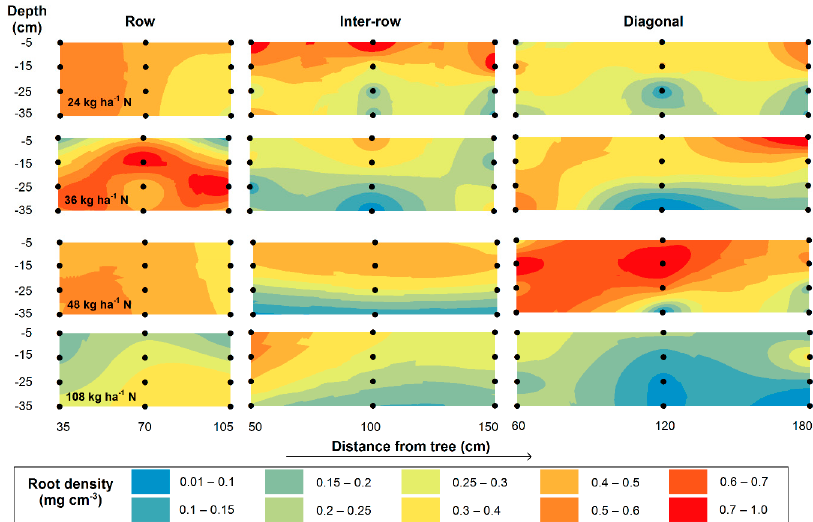
Figure 4. Ordinary kriging of average fine-root density ( FRD ) distribution of 2.95-year-old E. dunnii Maiden along soil profile in the three positions evaluated. Trees are placed in the top left corner of each figure. x axis represents increasing distance from tree in each position, and y axis represents depth.